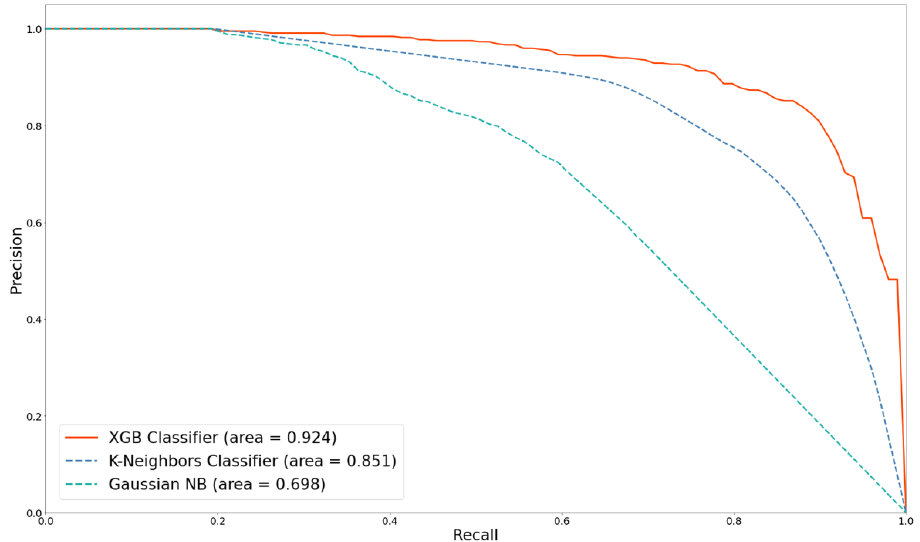
Figure 13. PR curves comparison with different classifiers.